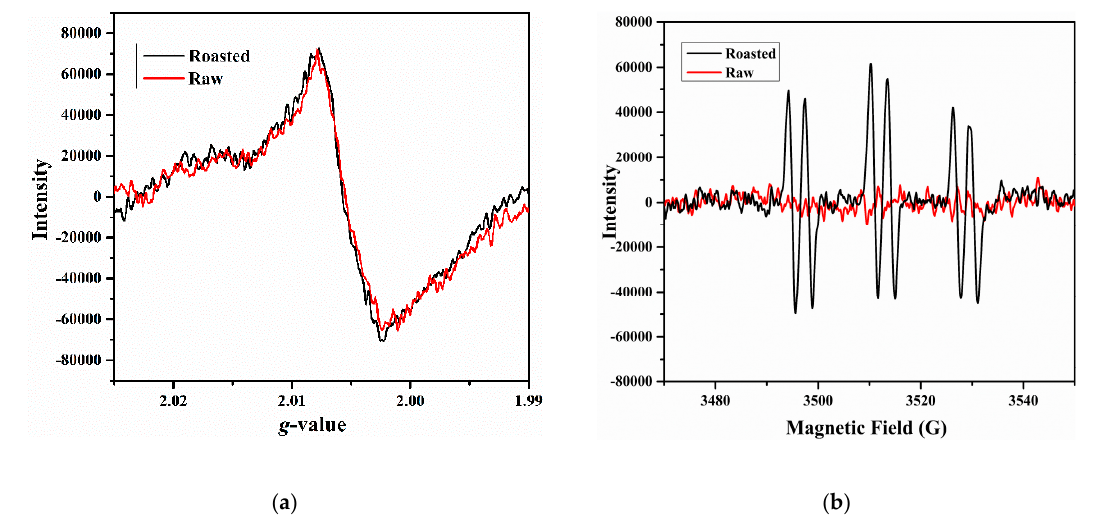
Figure 1. Electron spin resonance (ESR) spectra of roasted meat at 160 ◦ C for 20 min. ( a ) Solid powder from lyophilized roasted beef and lyophilized raw beef; ( b ) filtrate of roasted and raw beef incubated at 55 ◦ C for 1 h with PBN.